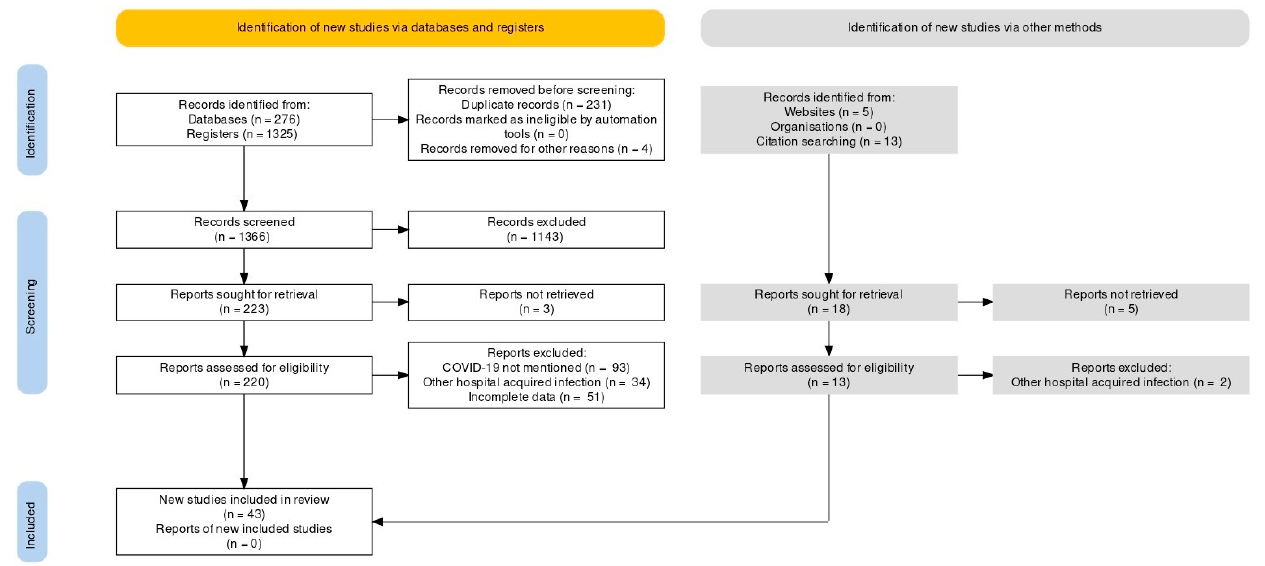
Figure 1. PRISMA Flow Chart.